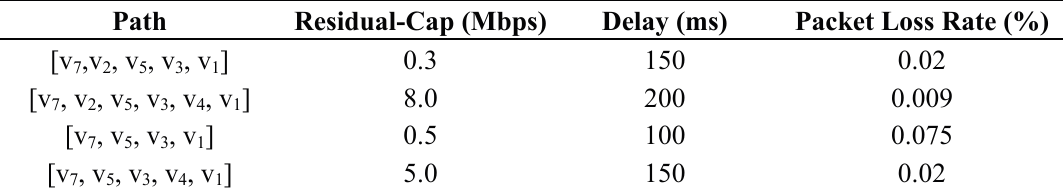
Table 5. Residual-cap delay and loss